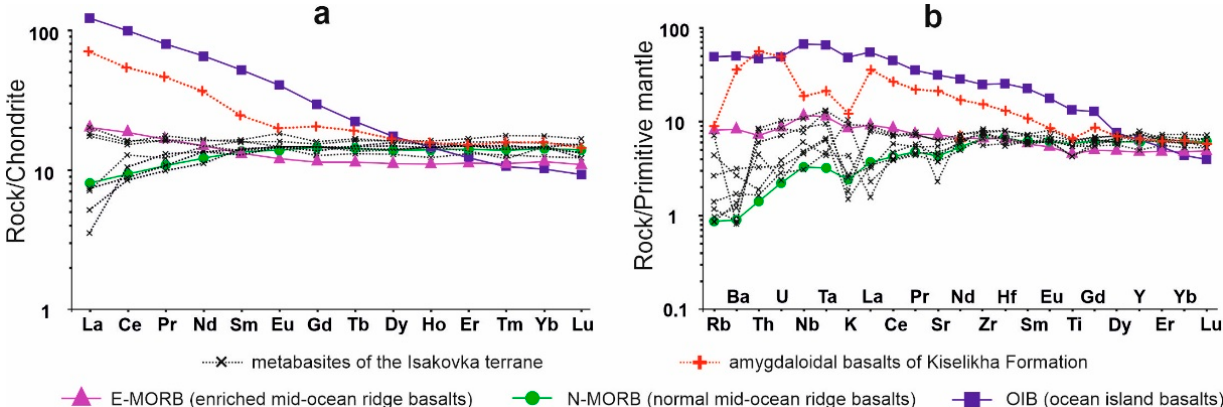
Figure 14. Chondrite-normalized REE patterns [98] (a) and primitive mantle-normalized spidergrams [99] (b) for metabasite tectonites of the Isakovka terrane in comparison with main types of basalts: N-MORB, E-MORB and OIB after